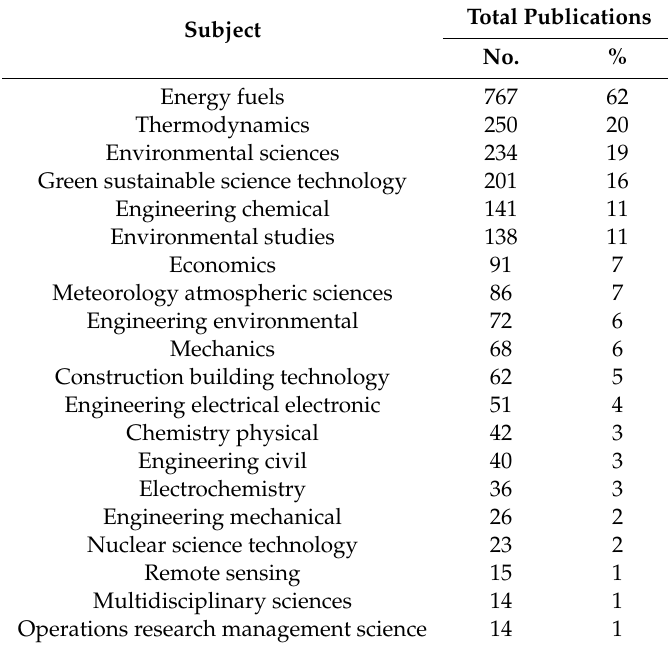
Table 9. The top 20 of the most relevant subjects in terms of publications on municipal energy system planning. The percentage values refer to the total of 1235